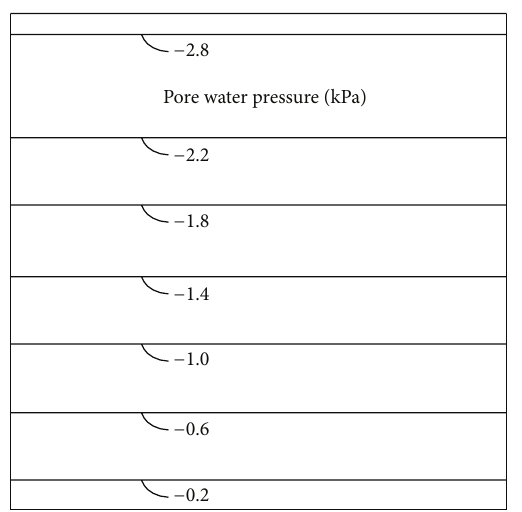
Figure 12: Pore water pressure contours after 185 minutes (with cracks).